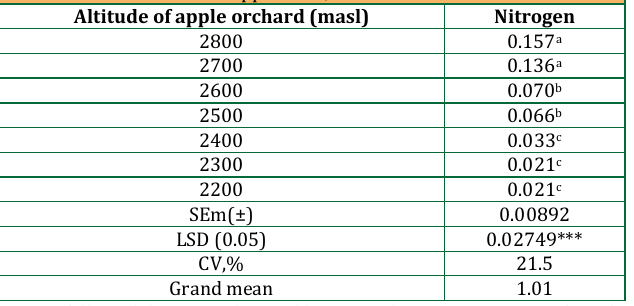
Table 7: Nitrogen variation in different altitude apple orchards in Apple Zone, Kalikot Altitude of apple orchard (masl)